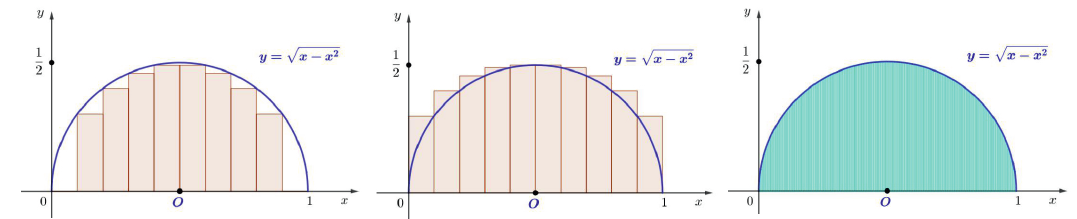
√ x − x 2 on a interval